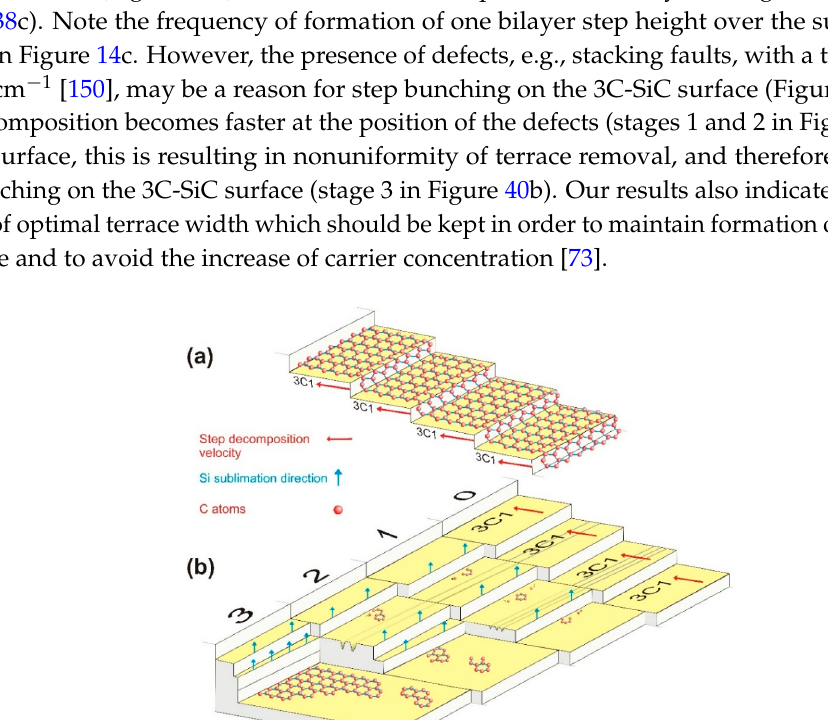
Figure 40. Graphene growth evolution (buffer layer formation not shown): ( a ) on a defect-free 3C-SiC substrate; ( b ) on a 3C-SiC with defects (lines indicate stacking faults) [22].